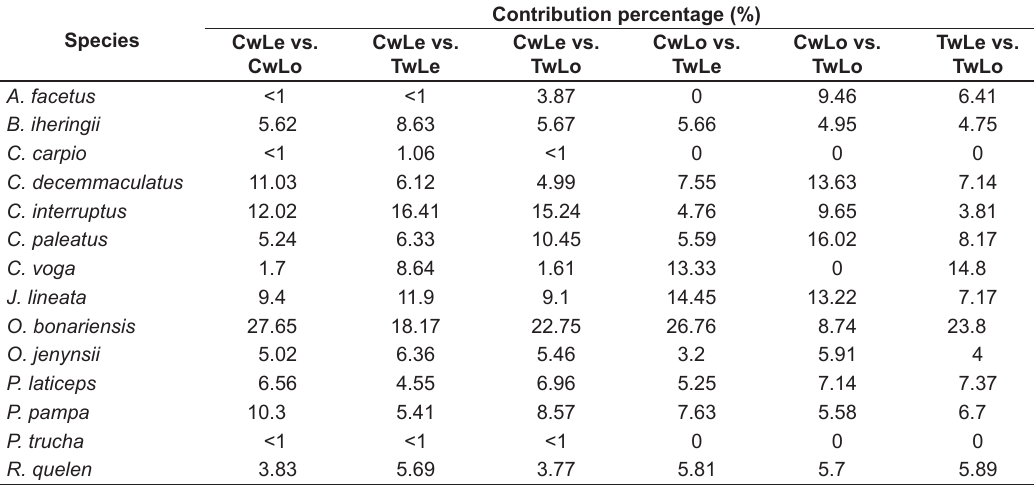
Table 3. Contribution percentage of specific abundances to different sampling sites in the Sauce Grande River using SIMPER